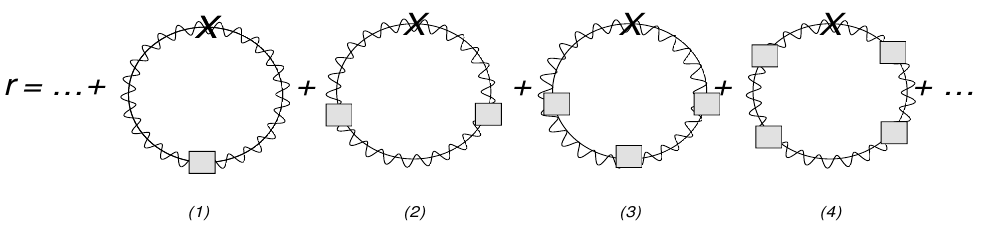
Figure 13 . Expansion of the